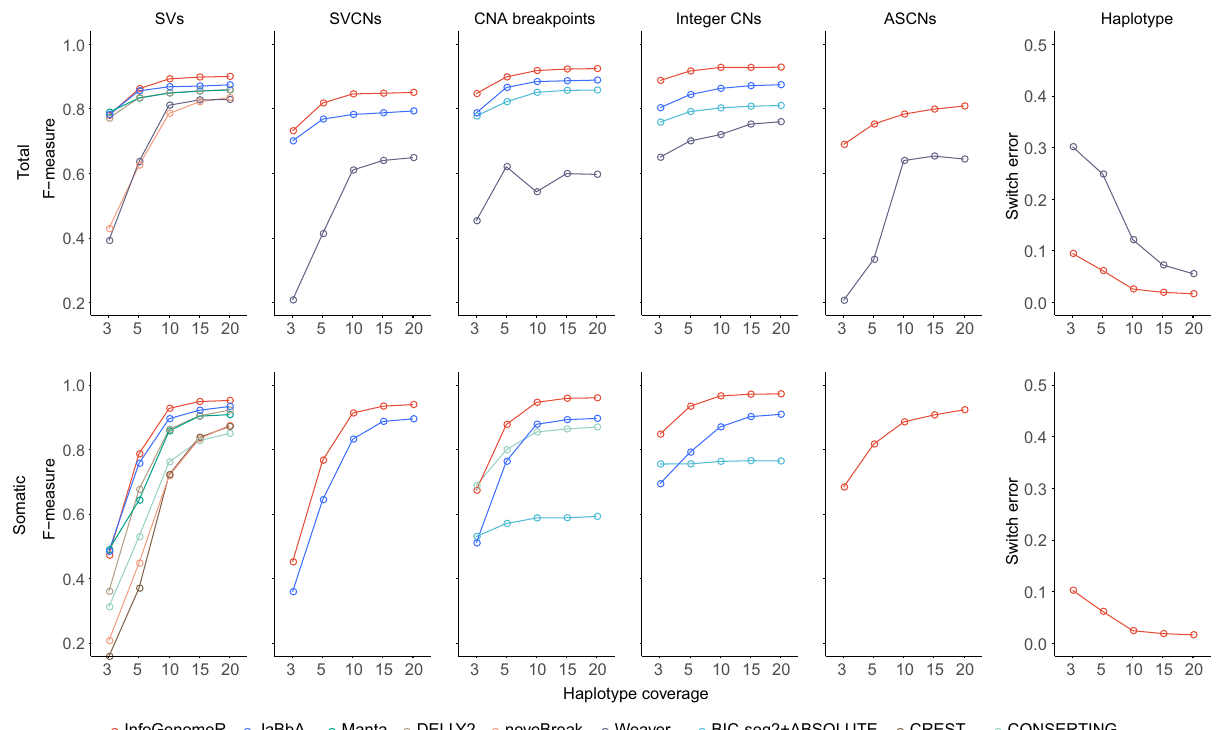
Fig. 2 InfoGenomeR performance with simulated data sets. F-measures were compared among variant-calling tools for fi ve variant-calling categories (SVs, SVCNs, CNA breakpoints, integer CNs and ASCNs) and switch error rates for haplotype, with controls (somatic variants), and without controls (total variants including germline and somatic variants). The x -axis denotes the haplotype coverage (3× to 20×), representing the mean number of reads aligned to a nucleotide in a